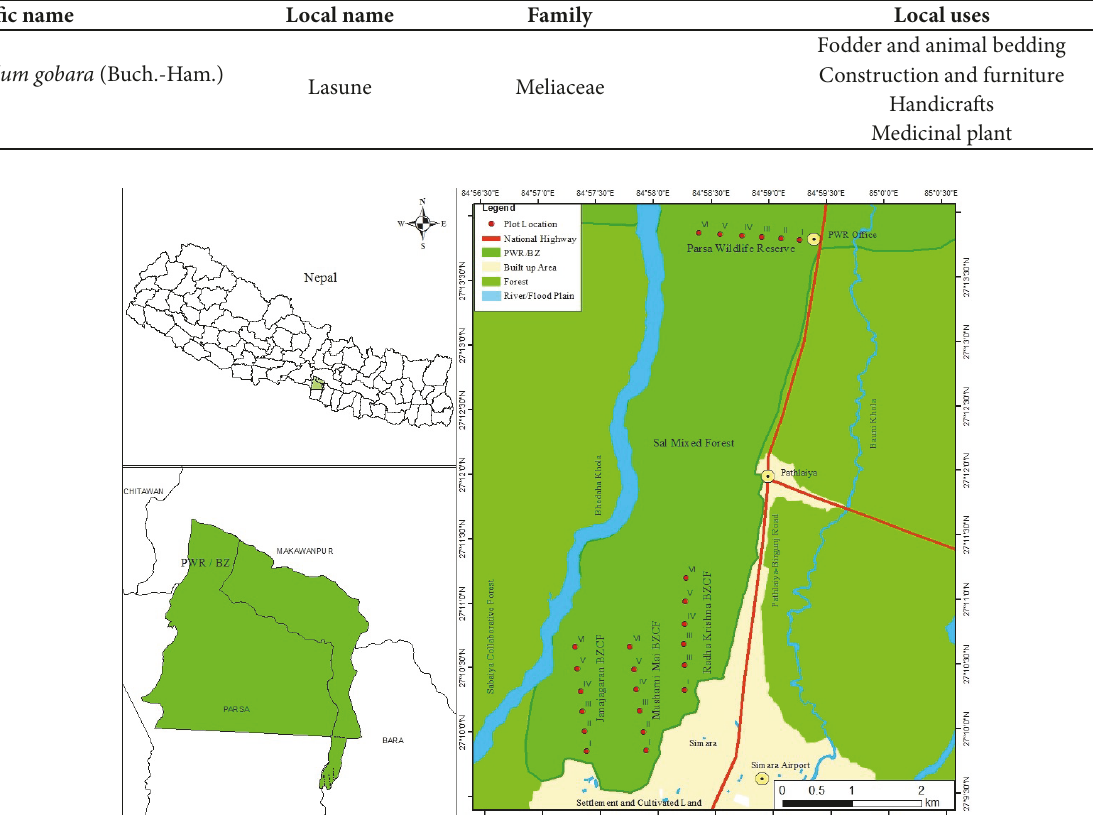
Figure 1: Locationof studied BZCFsand PWR forestin BaraDistrict,CentralTerai,Nepal. IntheseBZCFs, theforestusergroups aredifferent and also vary in a numberof households using forest resources. These BZCFs are the southernmost part of a large forest landscapealso known as “Charkose Jhadi”. People enter from the southern border of the BZCFs to collect/harvest forest